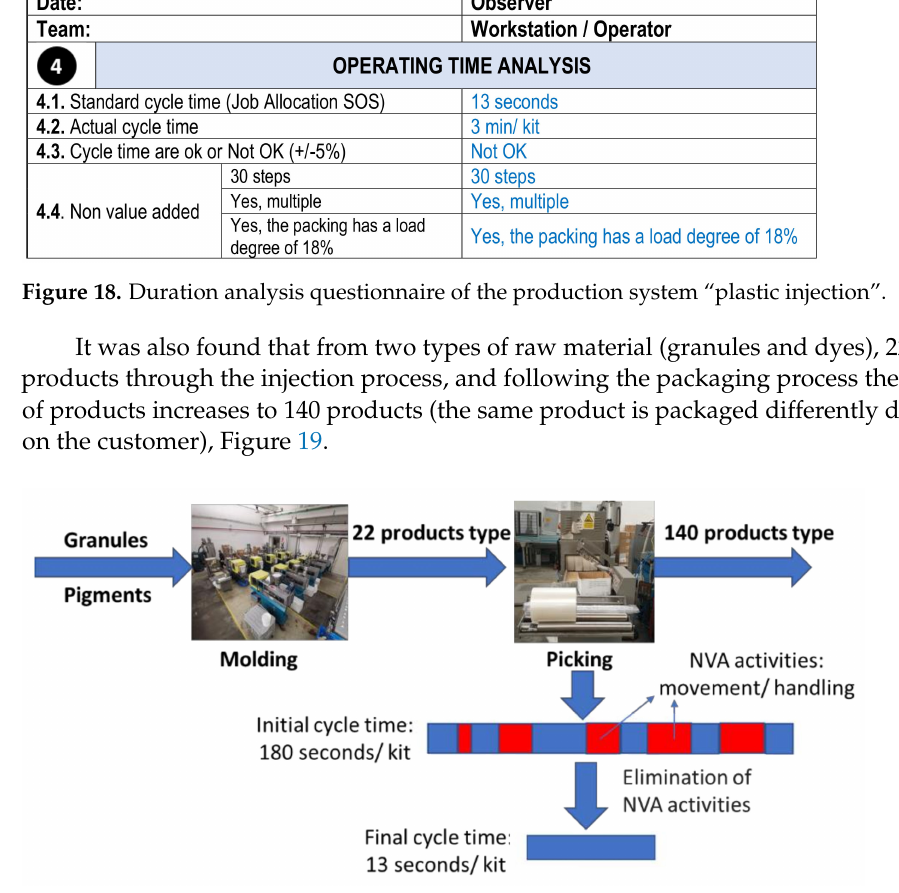
Figure 19. Products diversity evolution.